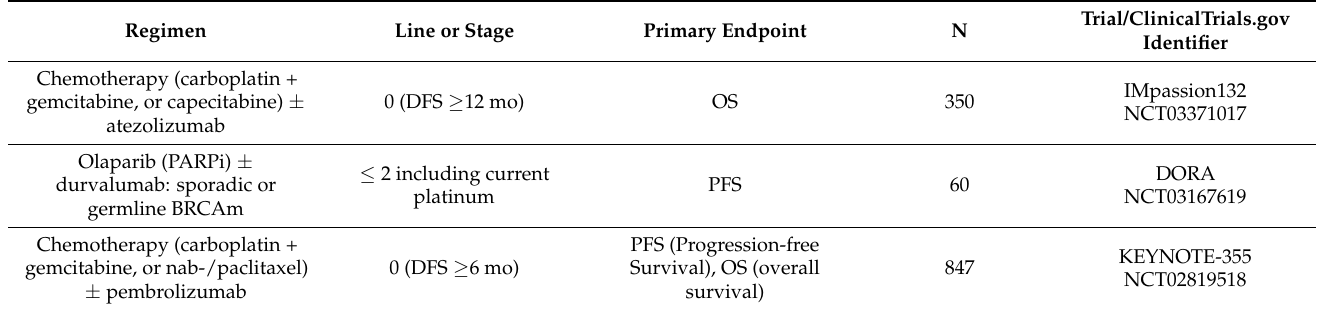
Table 7. Ongoing anti-PD-1/L1 novel immunotherapy trials in